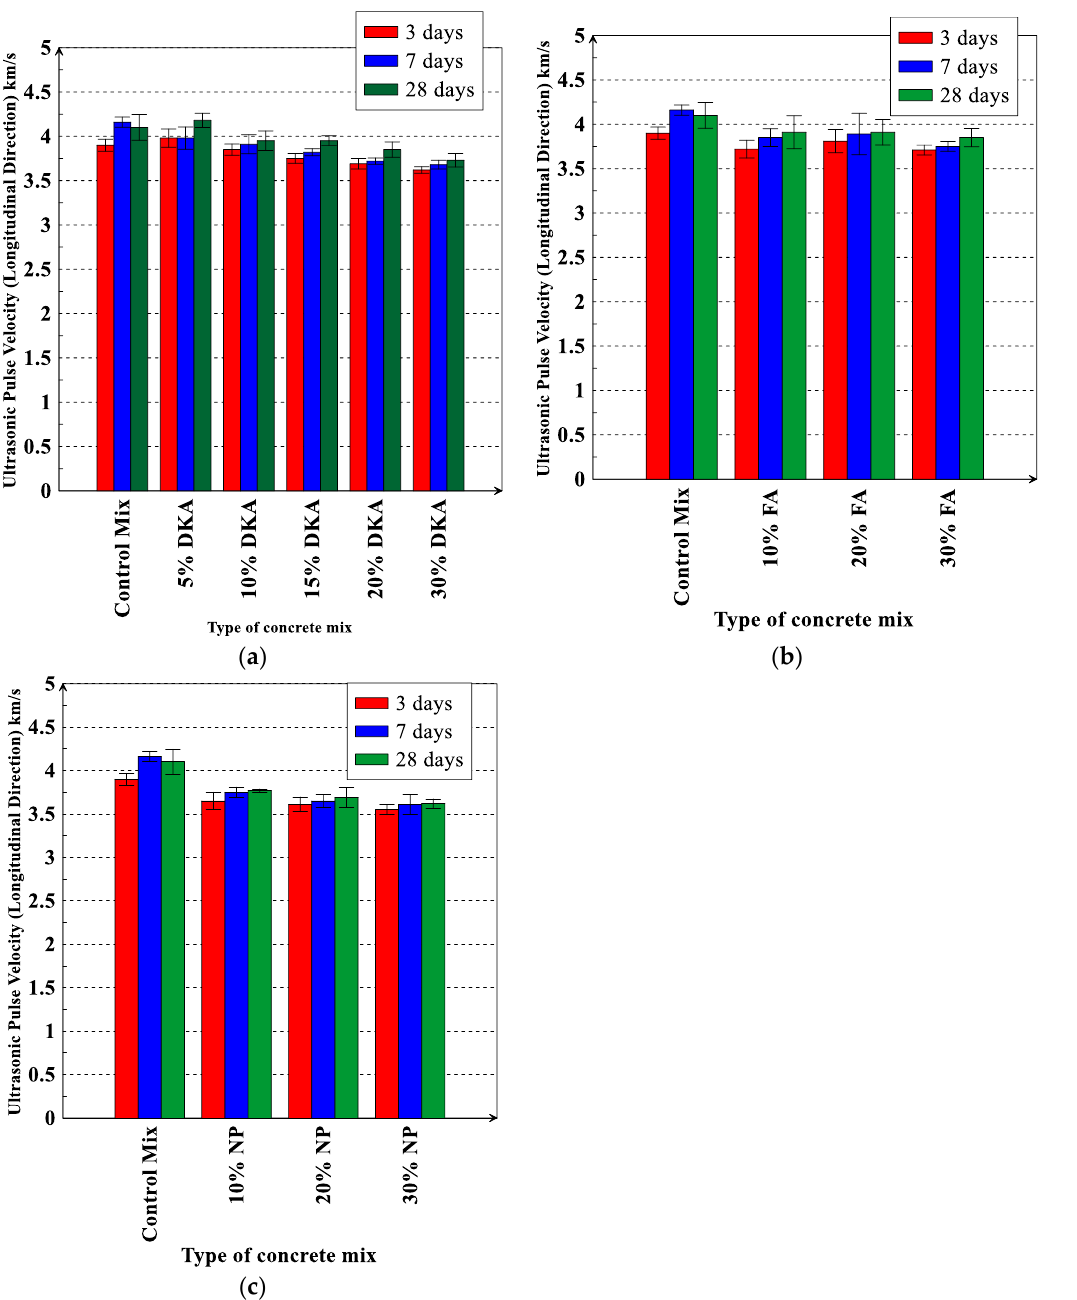
Figure 25. Ultrasonic pulse velocity of concrete mixtures for ( a ) DKA, ( b ) FA, and ( c ) NP. Error bars represent one standard deviation from the average of three specimens.